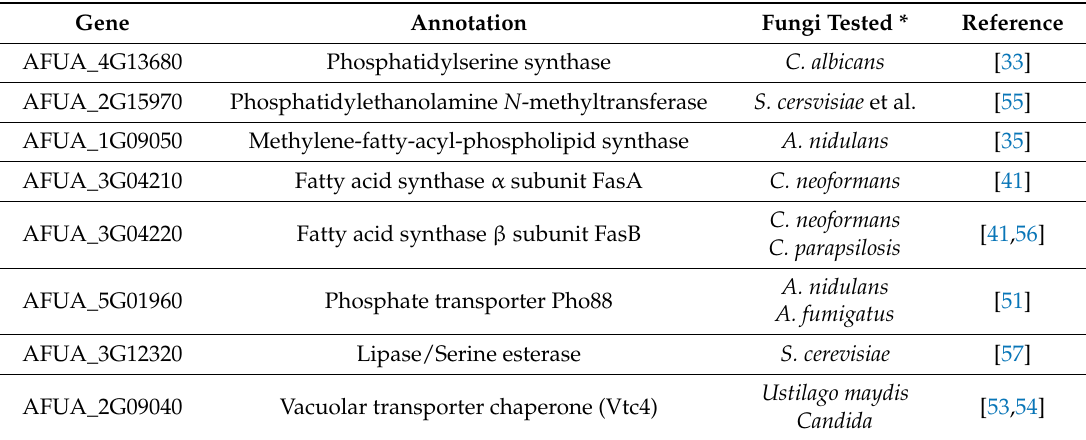
Table 3. Antifungal target proteins related to lipid